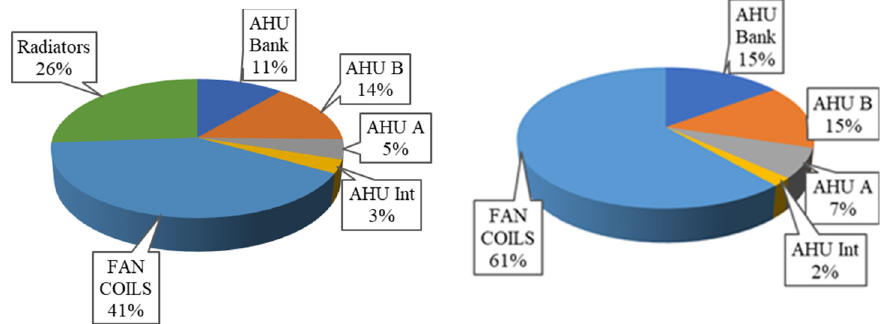
Figure 13. Energy distribution: heating (on the left ) and cooling (on the right ).